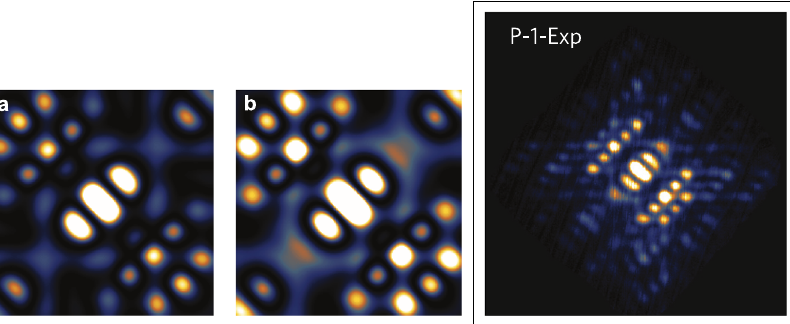
Fig. 6 Simulated STM images using optimized exponents for Slater orbitals. The left image ( a ) uses only the optimised exponent for s* while the ( b ) image additionally uses the optimised exponent for p x and p y . The additional black-bordered picture (P-1-Exp) representing the actual experimental data has been reprinted from ref. 3 (with courtesy from Springer Nature) for comparison.